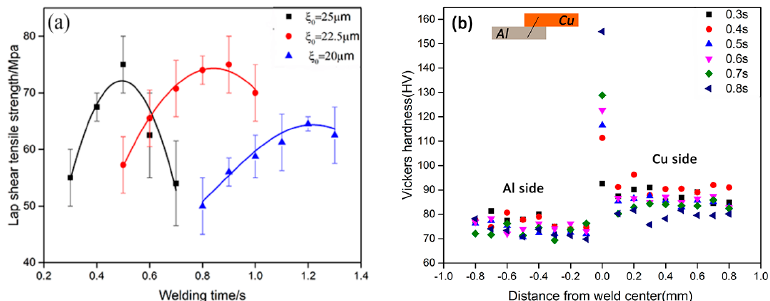
Figure 6. Mechanical performance of ultrasonic welded joints, ( a ) lap shear test results, ( b ) Vickers hardness measured at the amplitude of 25 μ m.